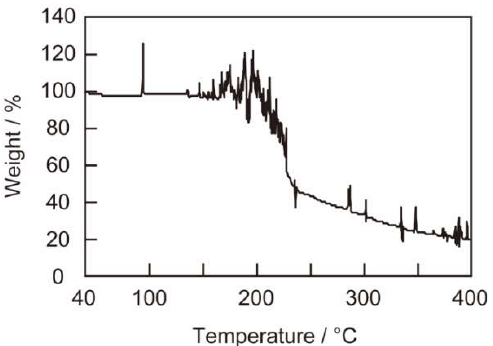
Figure 6. Thermogravimetric profile of the precipitate generated by a reaction mixture comprising (Ant 6 )-RU006 and metal ions (HAuCl 4 + H 2 PtCl 6 ). y-Axis shows weight changes of the precipitates relative to the weight at 40 °C as a function of temperature. The rate of the temperature increase was 5 K min −1 .